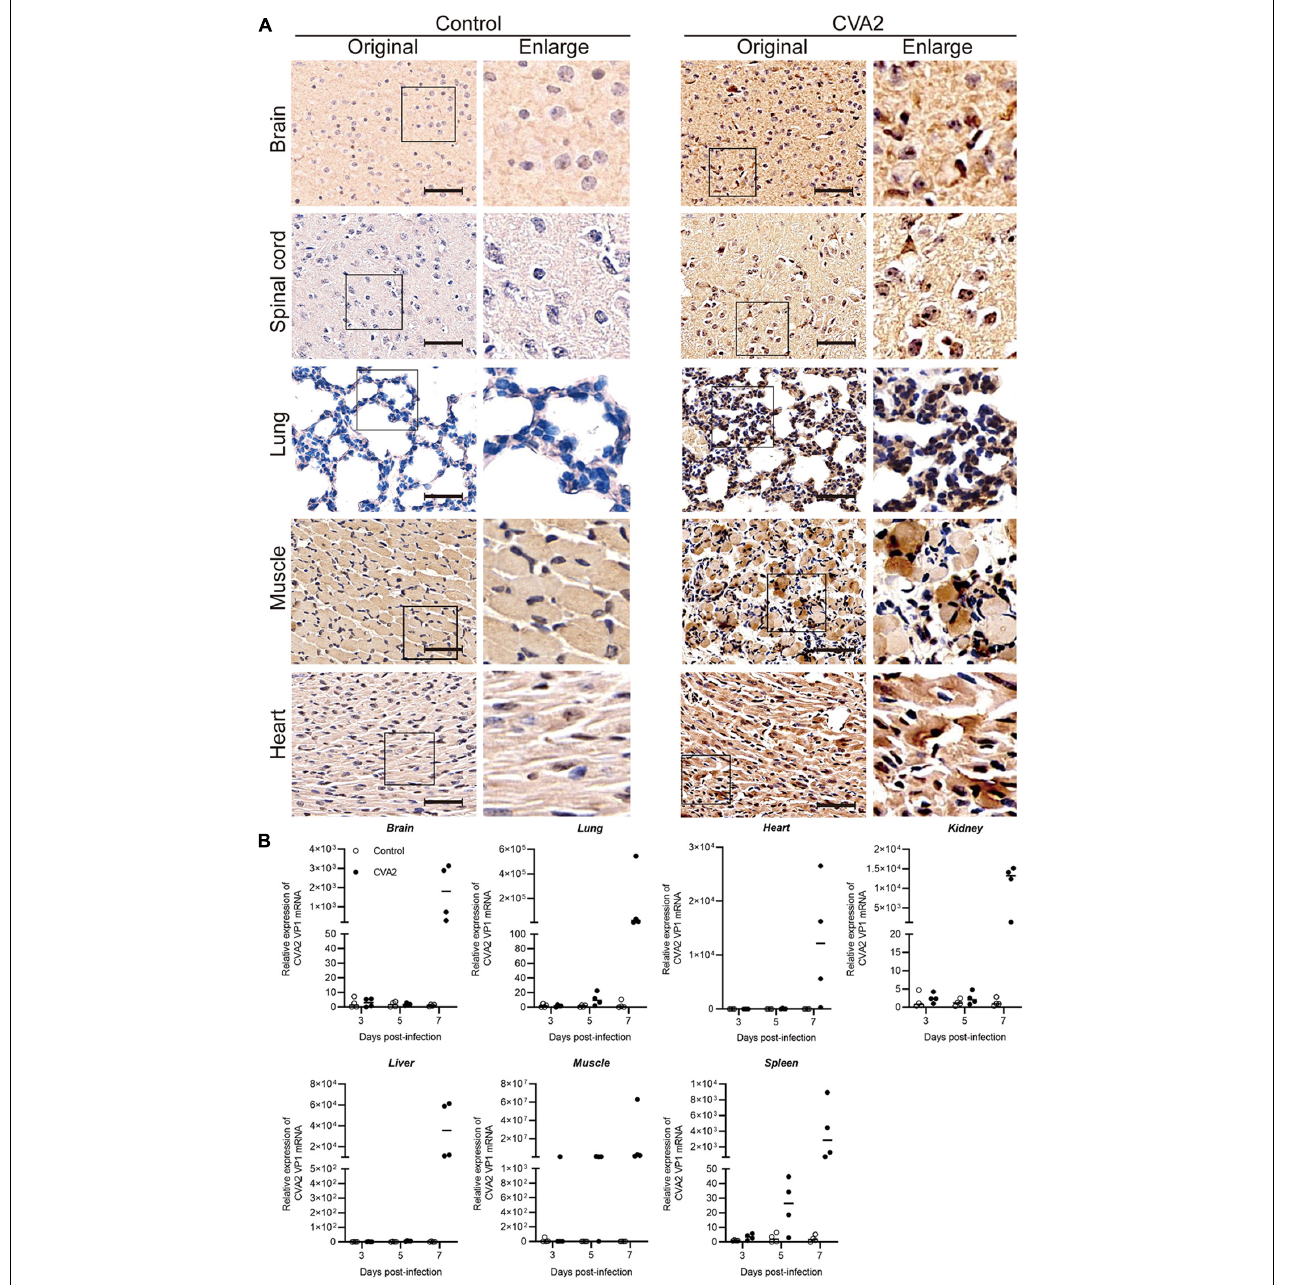
FIGURE 4 | Viral distribution in the tissues and organs of CVA2-infected mice. Immunohistochemical staining and CVA2 viral loads of infected 5-day-old mice after intramuscular challenge with lethal doses of CVA2 or medium (mock control). (A) The viral antigen was diffusely distributed in all the isolated tissues; no antigen was detected in the control group. Magnification: 500 × . All experiments were repeated for four times. (B) The viral loads of different organs (brain, lungs, heart, liver, spleens, kidney, and limb muscles) from mice infected with CVA2. Results are expressed as numbers of viral RNA copies normalized by β -actin from the same organ/tissue (n = 4 per